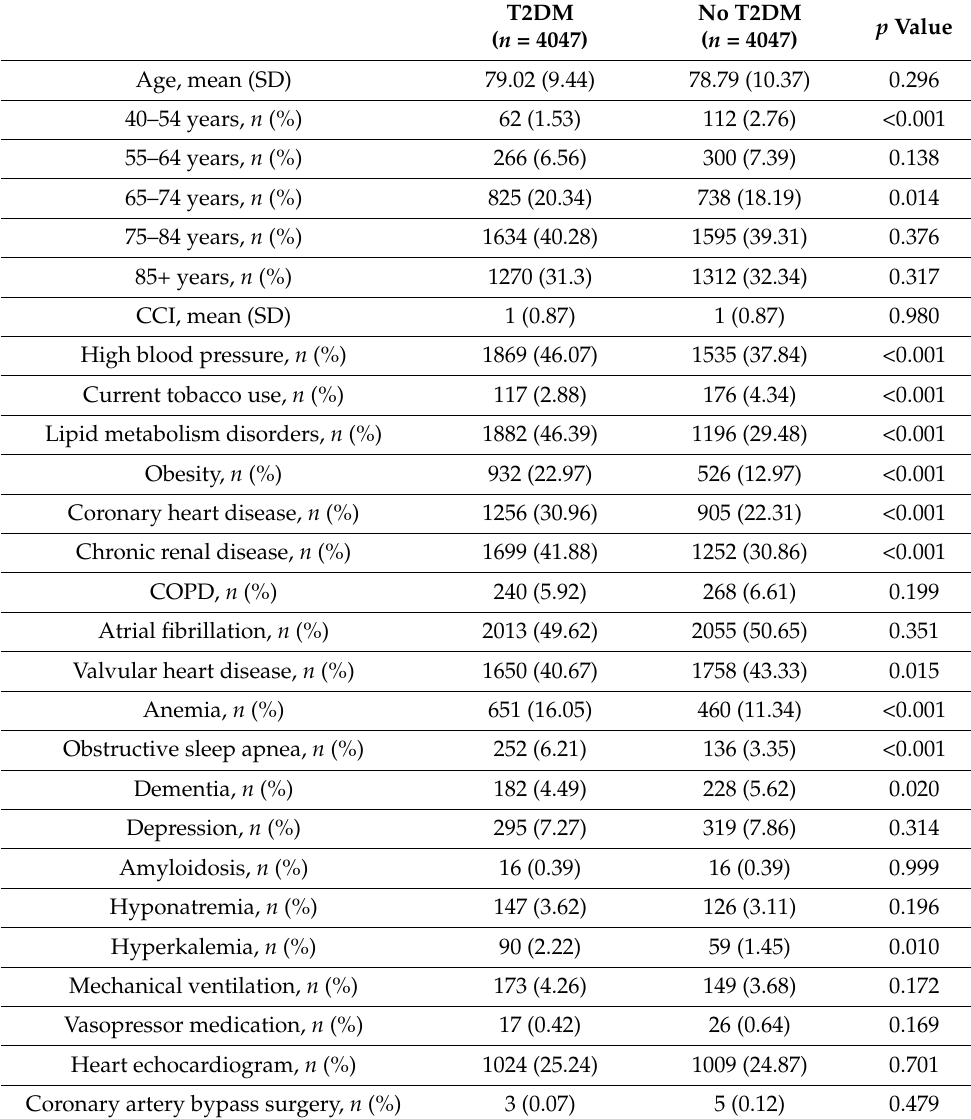
Table 3. Demographic and clinical characteristics, after propensity score matching, of women with and without type 2 diabetes mellitus hospitalized with systolic heart failure in Spain from 2016 to